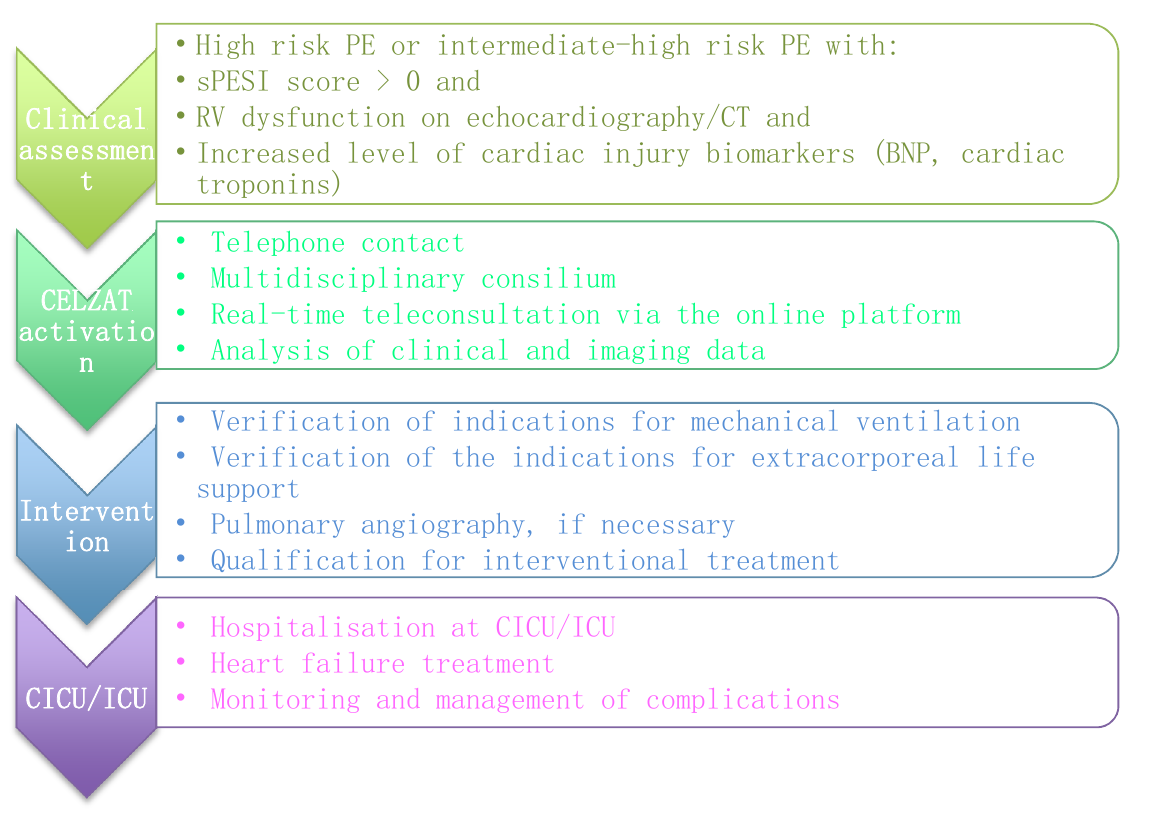
Figure 1. Activation flowchart of CELZAT. PE—pulmonary embolism, sPESI—simplified Pulmonary Embolism Severity Index, RV—right ventricle, CT—computed tomography, BNP—brain natriuretic peptide, CICU—cardiac intensive care unit, ICU—intensive care